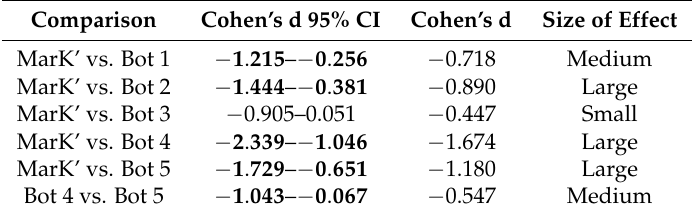
Table 4. Skill Level Analysis for